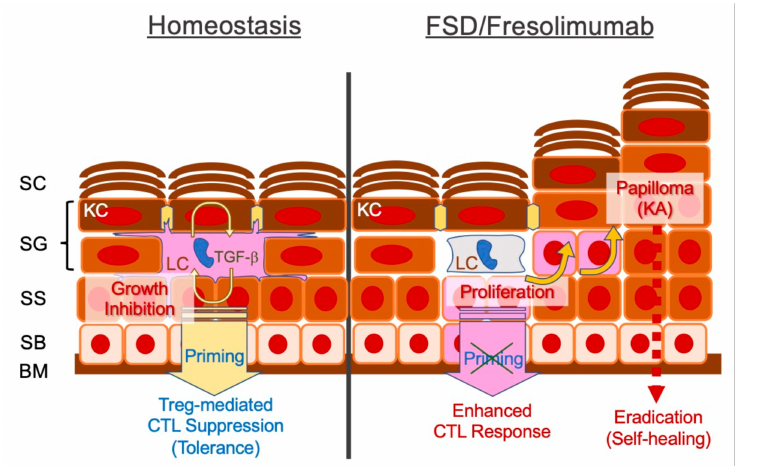
Figure 1. Schematic representation of defective transforming growth factor-beta (TGF- β ) signaling in the epidermis and possible pathomechanisms of self-healing squamous epithelioma observed in Ferguson–Smith disease (FSD) or after treatment with the TGF- β antibody fresolimumab. Epidermal Langerhans cells (LCs) require an autocrine/paracrine loop of TGF- β . LCs establish an intercellular network of differentiated epidermal layers, induce tolerance in steady state and protect against potentially harmful cytotoxic T cell (CTL)-mediated immune responses. Disrupted TGF- β signaling may augment keratinocyte DNA synthesis, facilitating the formation of epitheliomas (papillomas), whereas unleashed CTLs eradicate the tumor. BM, basement membrane; SB, stratum basale; SS, stratum spinosum; SG, stratum granulosum; SC, stratum